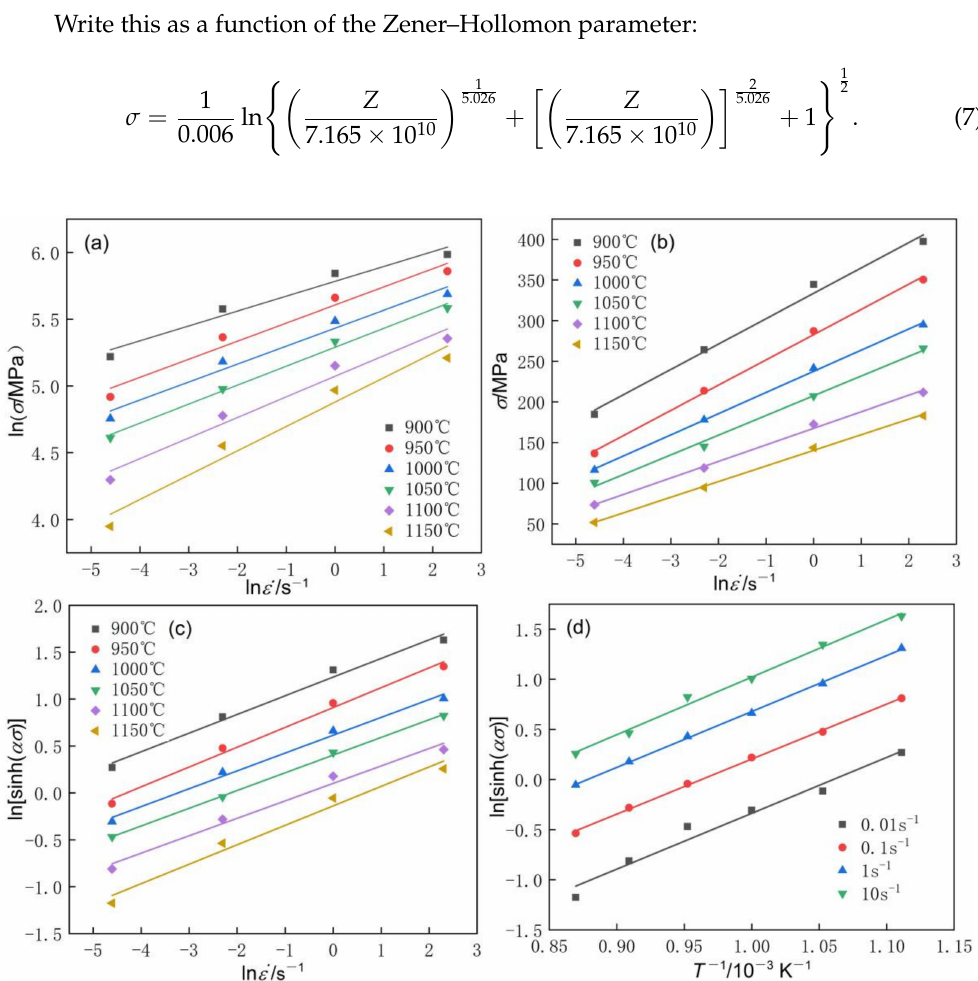
. . ε , ( b ) σ − ε , ( c ) ln [ sinh ( ασ )] − ln